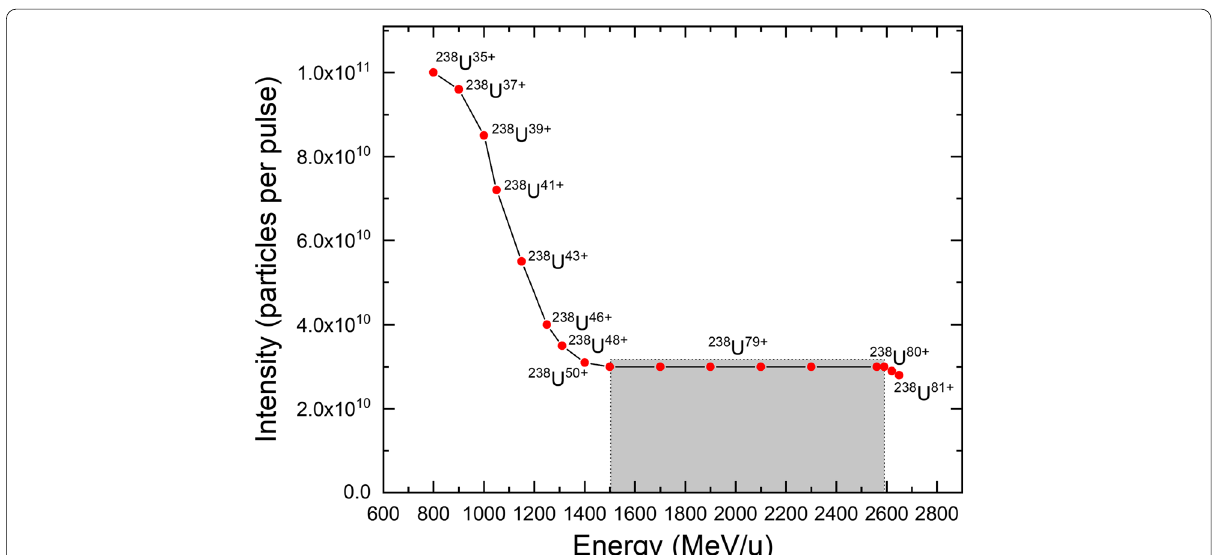
Fig. 3 Intensity-energy diagram of 238 U beam stored in the booster. The red dots represent the maximum particle numbers stored at the corresponding charge